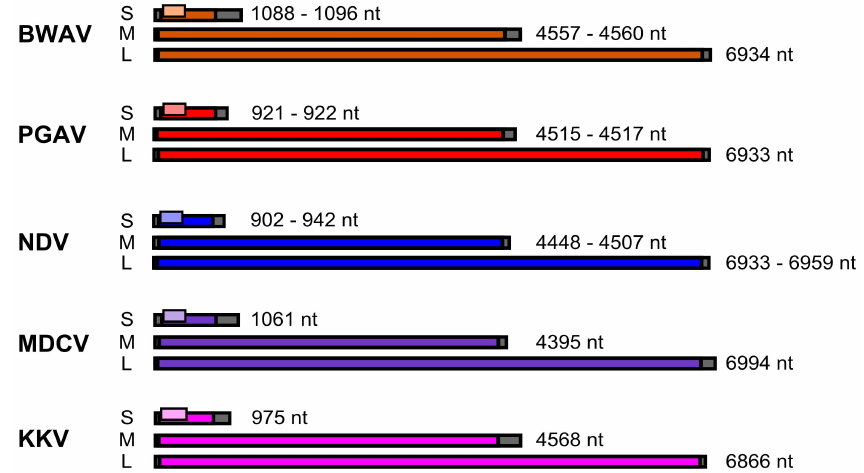
Figure 3. Comparison of virus genome structures. The genomes of the various virus groups sequenced in this study are shown to scale. The non-coding regions are shown in grey while the major open reading frames encoded by each segment [S segment: N (ORF), M segment: GPC (ORF) and L segment: LORF)] are shown in colored boxes. The NSs protein, which is produced from a downstream ATG in the S segment, is shown in a lighter shade of the corresponding color for each virus. The total genome length of each segment is indicated at right.